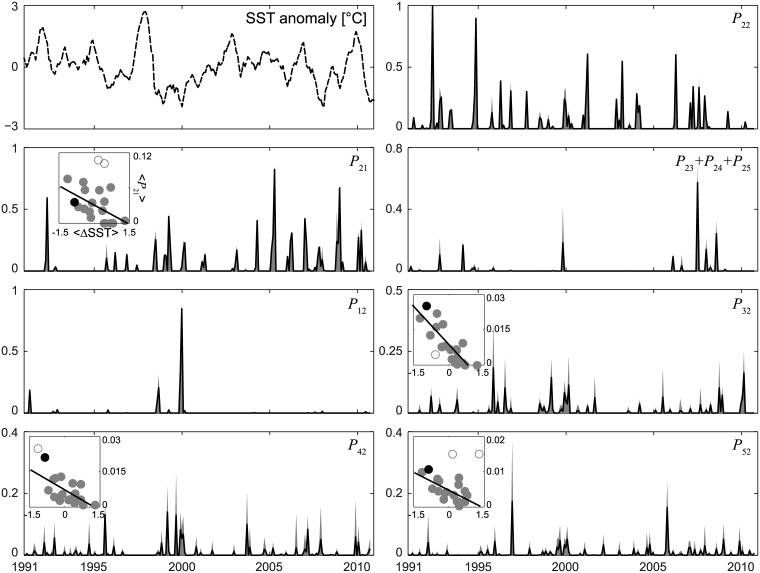
Relationship between ENSO SST anomaly and connectivity.ENSO SST anomaly (top-left panel) and connectivity patterns for the period 1991–2010. Black solid lines represent monthly connectivity scores (obtained with β = 10 km) averaged over the set of PLDs considered in Fig 6, while the gray shaded areas report the min-max range of the connectivity scores. Insets are reported only for statistically significant correlations (p < 0.05) between yearly averages of the SST anomaly (〈ΔSST〉) and yearly averages of connectivity scores (〈Pij〉, dots; year 2000 is highlighted in black). Regression lines obtained after the removal of outliers (white filled dots), identified by computing confidence intervals for each observation based on the associated (externally) studentized residuals (see e.g. [45, 47]), are shown as solid lines within insets.